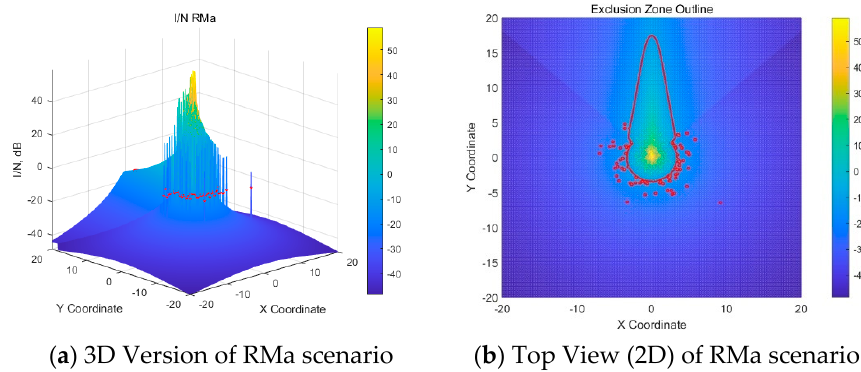
Figure 10. RMa scenario with ES antenna elevation angle of 5°.